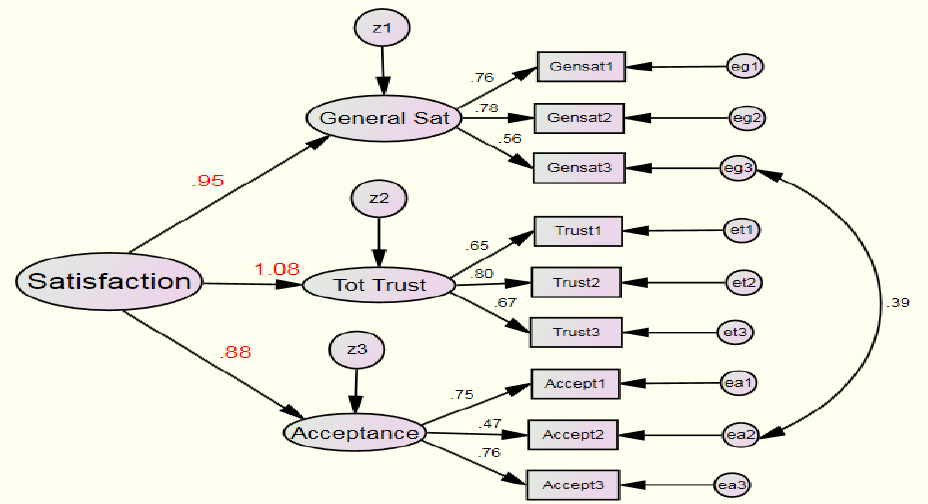
Fig. 4. The second-order conformity factor analysis (measurement model) For patient